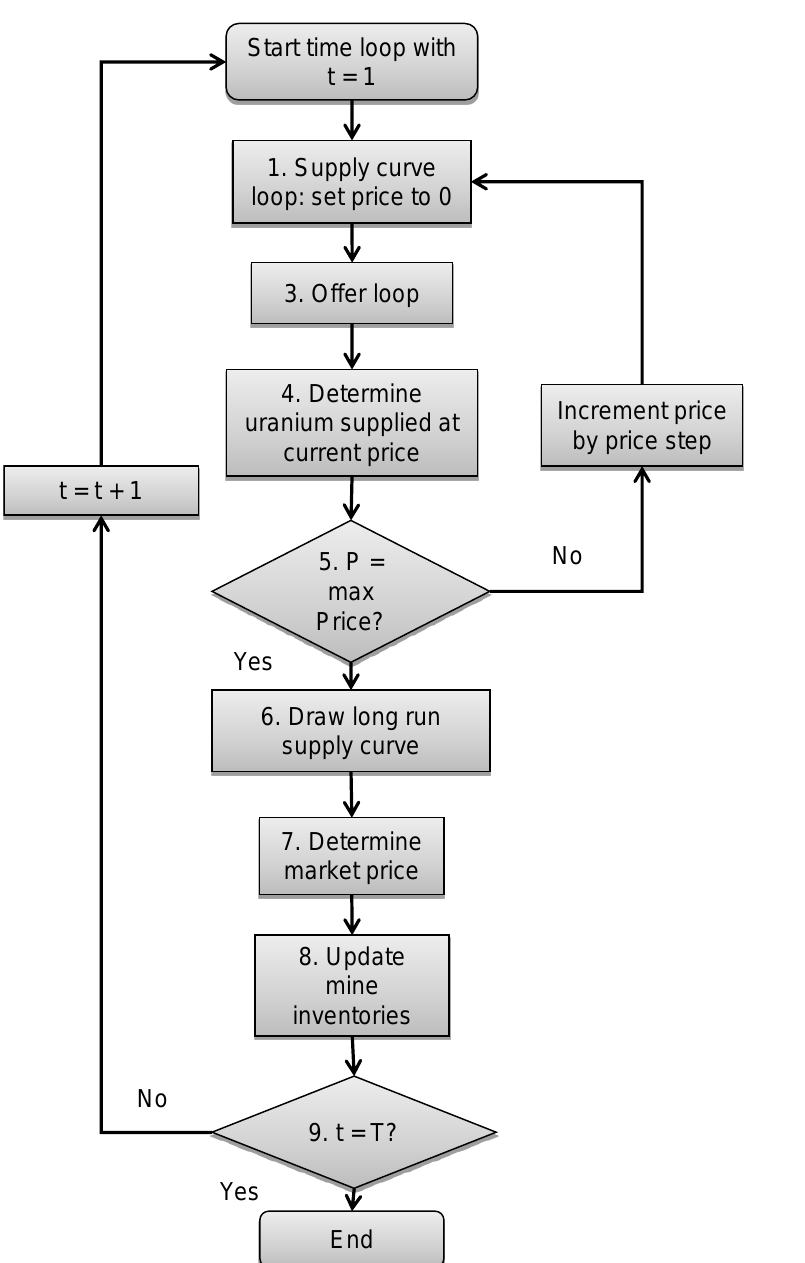
Figure 3. Main time loop